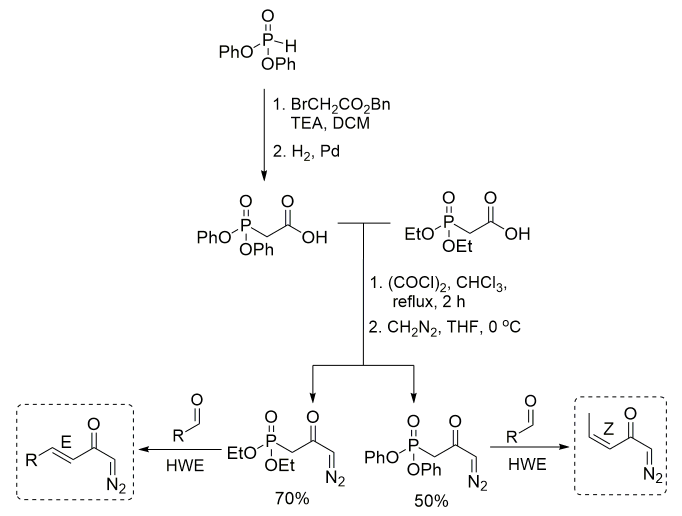
Figure 7 - Burtoloso’s synthesis of Z and E α,β-unsaturated